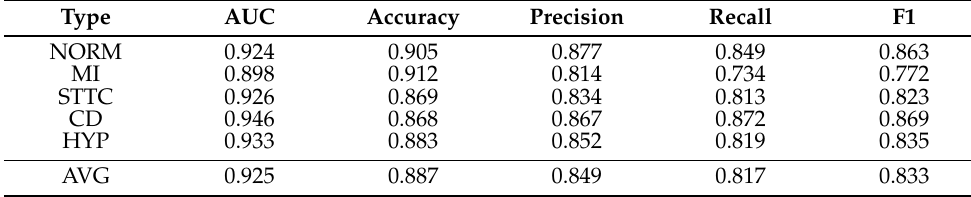
Table 3. Classification performance of the proposed method on the PTB-XL dataset.